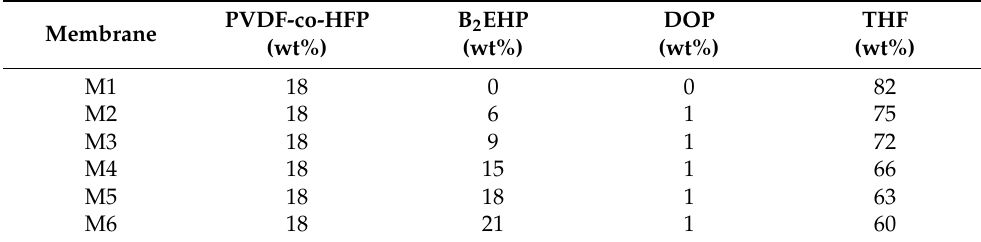
Table 2. Formulation of PIMs in this